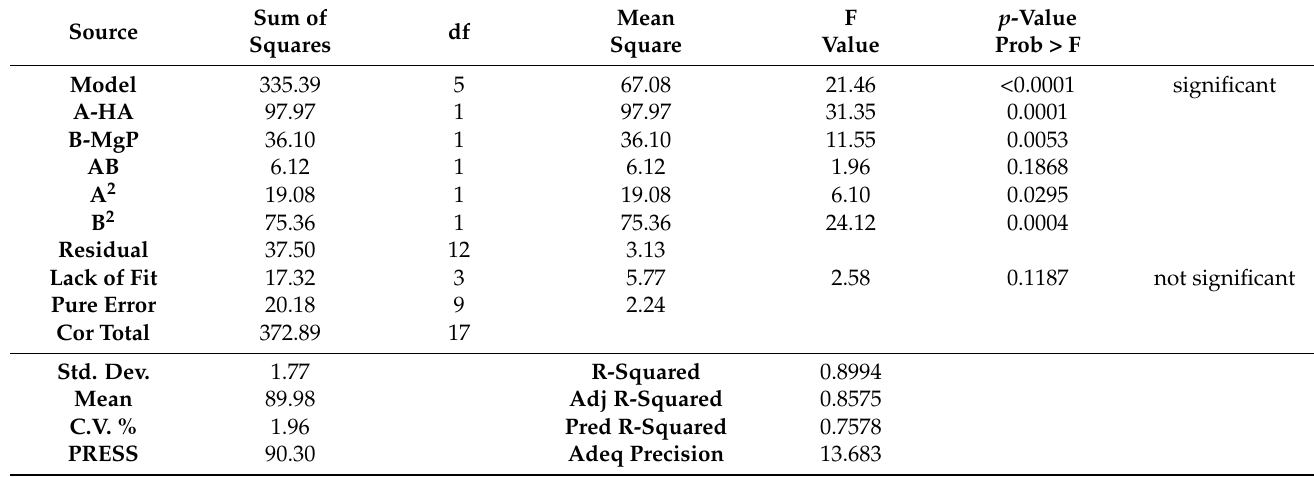
Table 4. ANOVA table for the reduced quadratic model (cell